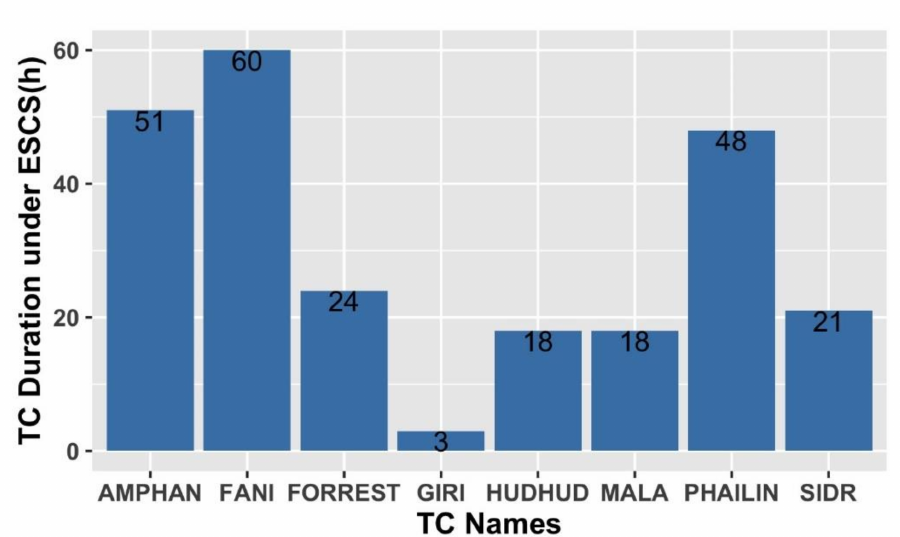
Figure 1. Duration (in hours) of tropical cyclones in the extremely severe cyclonic storm (ESCS) category over the BoB. TC names are mentioned along with the number of hours spent in the ESCS category on each bar. Data used for the duration of years 1990–2020 from the IMD data available from IBTrACS (https://www.ncei.noaa.gov/data/international-best-track-archive-for- climate-stewardship-ibtracs/v04r00/access/csv/) (accessed on 15 December